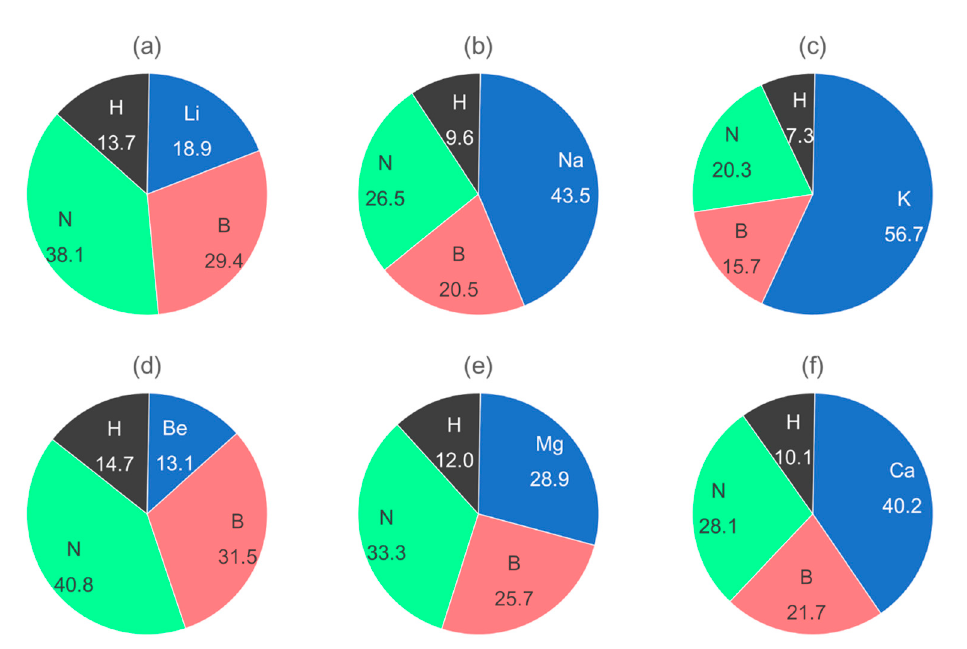
Figure 18. Weight percentage of hydrogen, boron, nitrogen and alkali or alkaline-earth atoms for the amidoboranes of ( a ) lithium, ( b ) sodium, ( c ) potassium, ( d ) beryllium, ( e ) magnesium and ( f ) calcium. The weight percentage of hydrogen is the gravimetric hydrogen density or gravimetric hydrogen storage capacity (in wt% H 2 ) of the amidoborane.